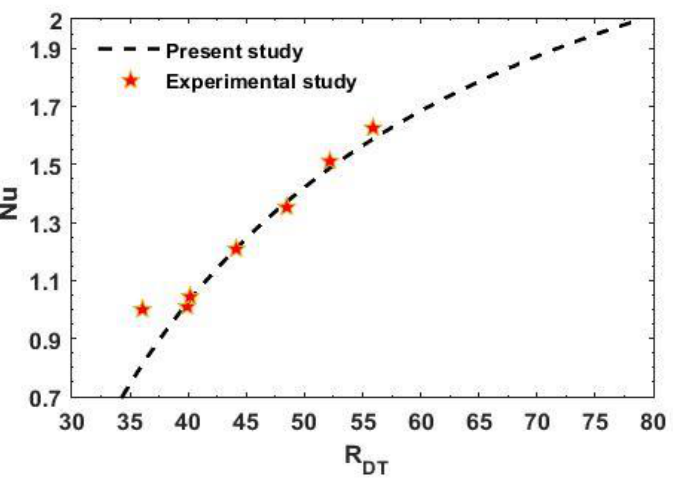
Figure 12. Contrast of the Nusselt number Nu in the particular case of the present analysis with experimental results found by Serkitjis [77].